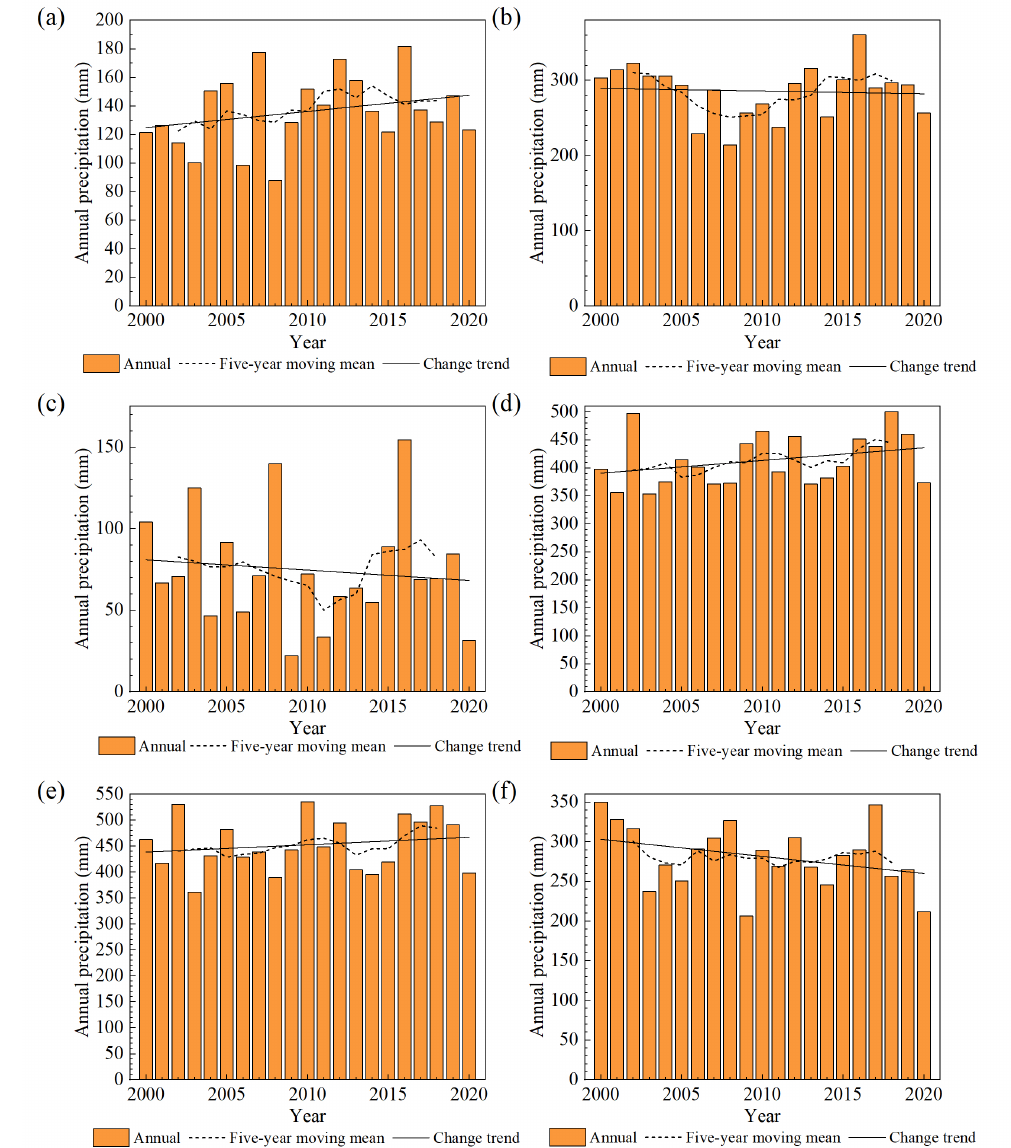
Figure 8. Precipitation of six lakes in Xinjiang from 2000 to 2020 ( a ) Ulungur Lake; ( b ) Manas Lake; ( c ) Bosten Lake; ( d ) Ayakkum Lake; ( e ) Aqqikkol Lake; ( f ) Aksayquin